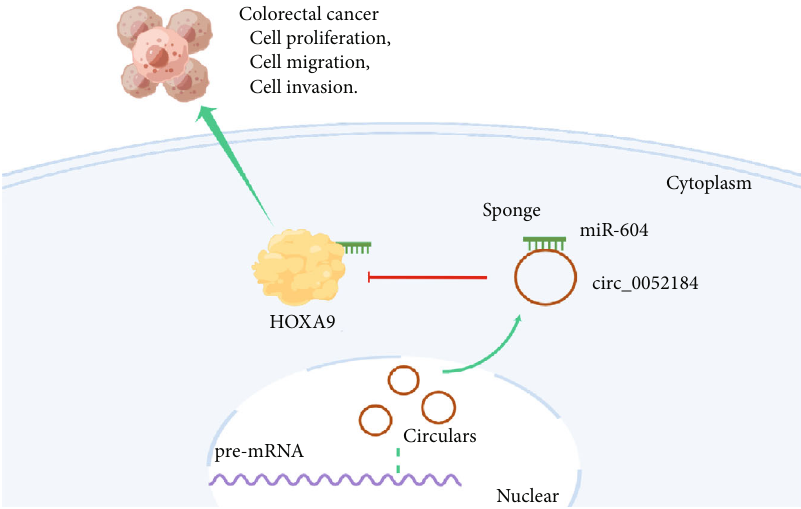
Figure 6: Schematic diagram: circ_0052184/miR-604/HOXA9 axis promotes the progression of colorectal cancer cell (by